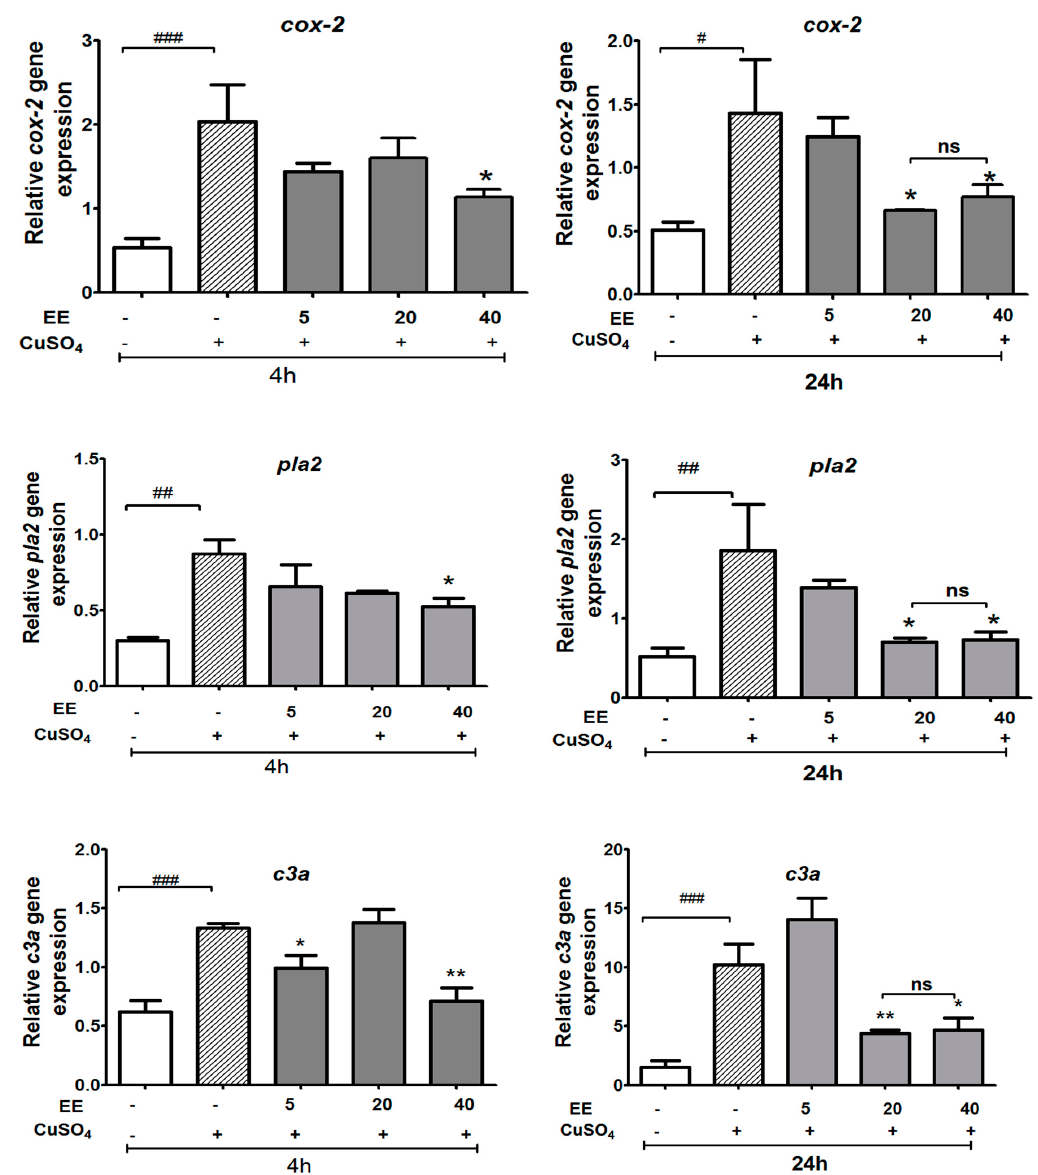
Figure 5. E ff ect of ethanol extract (EE) of C. cyrtophyllum Turcz leaves on the expression of genes in the eicosanoid pathway ( pla2 , cox-2 , and c3a. ). The zebrafish larvae were exposed to EE for 1 h and CuSO 4 10 µ M for 4 and 24 h. After 4 or 24 h, larvae were collected for qPCR analysis. The relative gene expressions are presented as the ratio of the quantity of candidate gene / average quantity of housekeeping genes. A pool of 20 larvae per group (n = 3) was used. Each bar represents the mean ± S.E. for three di ff erent experiments performed in triplicate. * p < 0.05, ** and ### p < 0.01, and *** p < 0.001 compared to the CuSO 4 alone